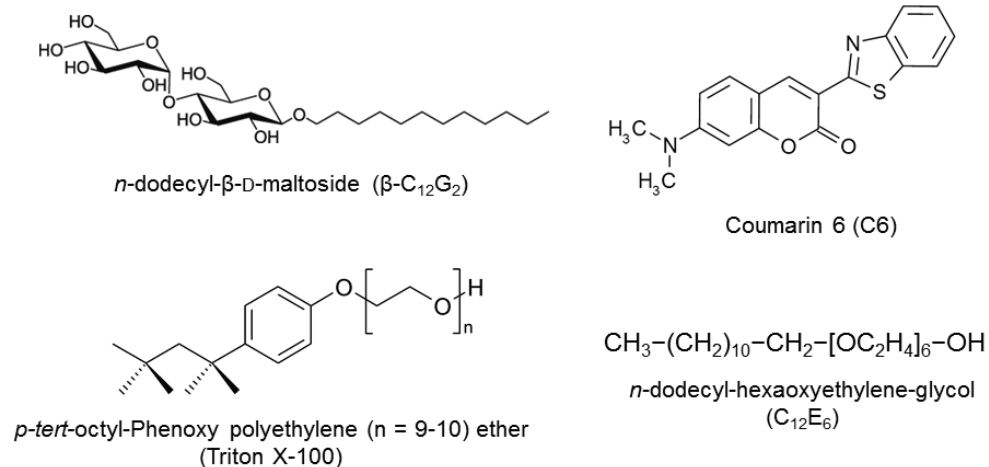
Figure 1. Molecular structures of the surfactants and fluorescence probe molecule used in the present